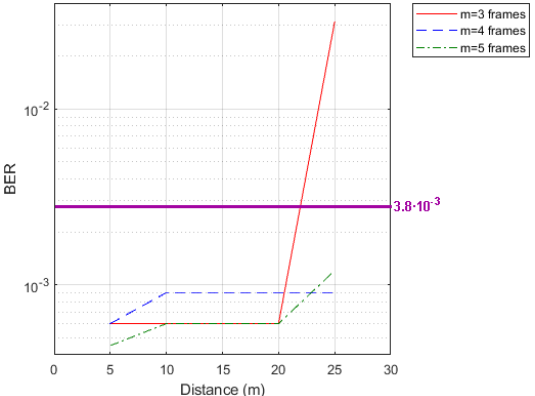
Figure 14. Communication BER for α = 15.